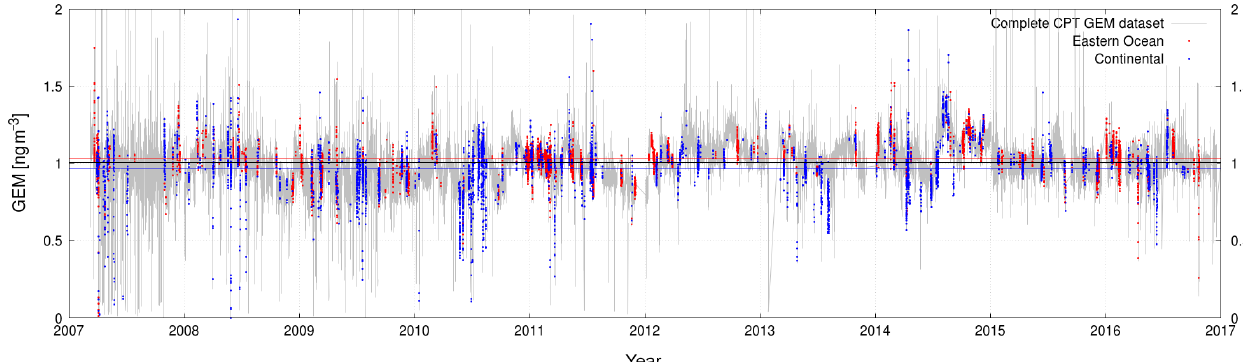
Figure 10. Complete Cape Point dataset (grey) with observations originating from source (red) and sink (blue) regions superimposed. The coloured x axis parallel indicates the long-term average (black: complete dataset; red: source region; blue: sink